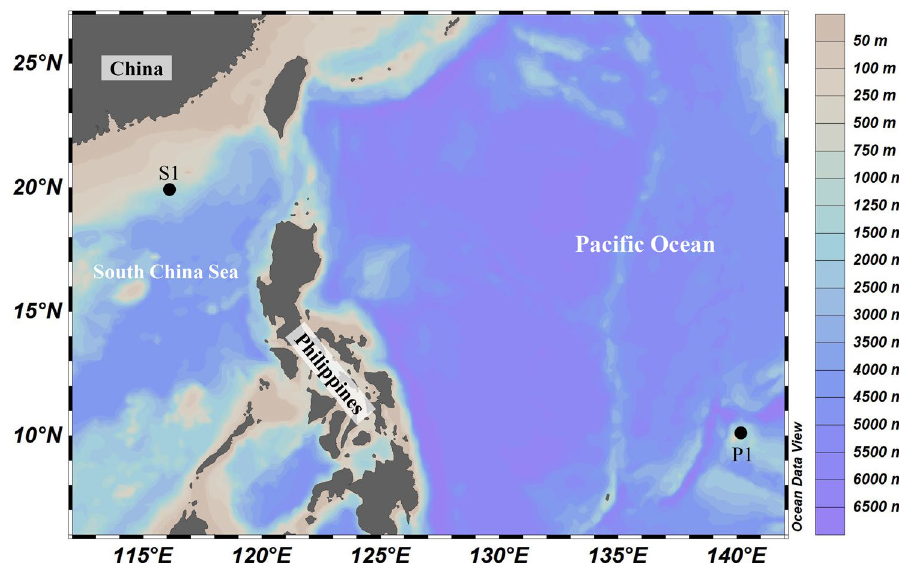
Figure 7. Survey stations in the northern South China Sea (nSCS) and tropical West Pacific